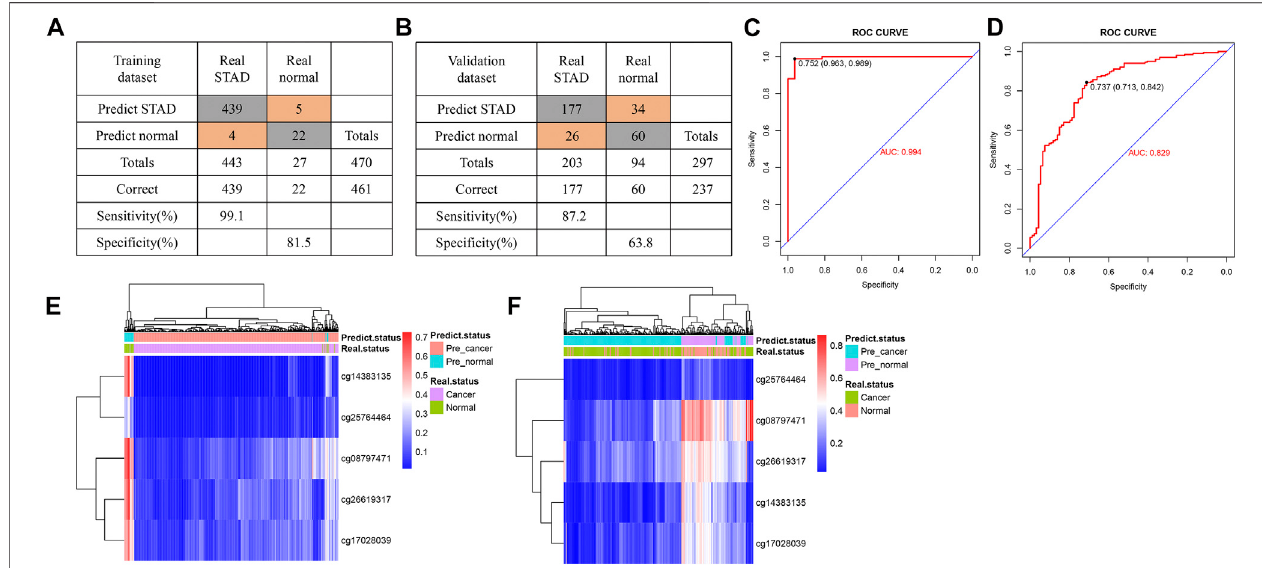
FIGURE 3 | Construction of a diagnostic model of DNA methylation (DNAm) in gastric cancer. (A,B) Confusion tables of binary results of the diagnostic prediction model in the training (A) and validation datasets (B) . (C,D) Receiving operating characteristics curve analysis of the diagnostic prediction model with DNAm markers in the training (C) and validation datasets (D) . (E,F) Unsupervised hierarchical clustering of fi ve DNAm markers selected for use in the diagnostic prediction model in the training (E) and validation data sets (F)